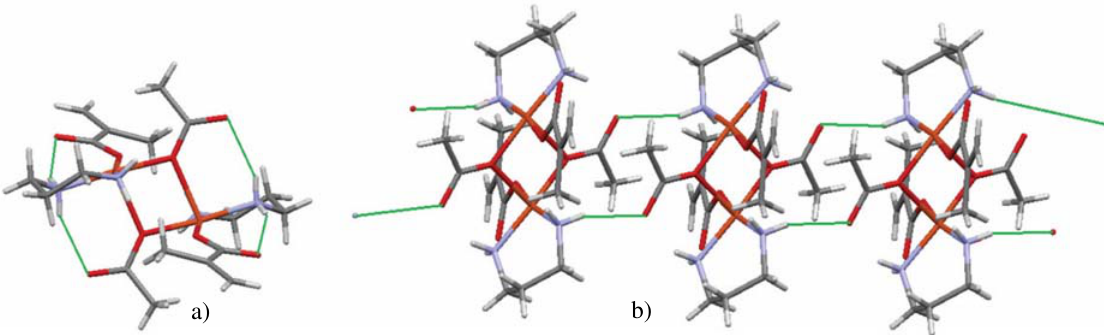
Fig. 3. Various hydrogen bonding interactions in complex 2 (a) intramolecular (b),